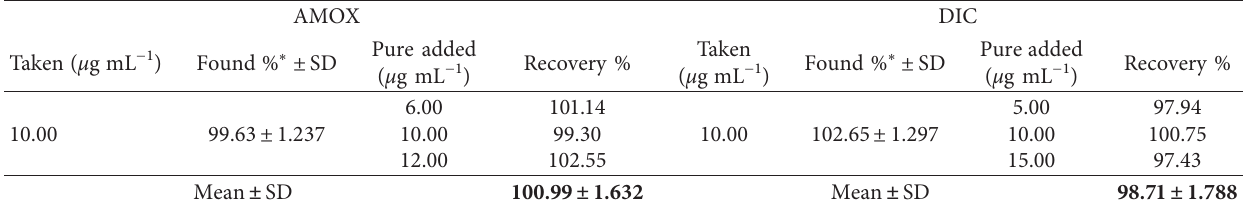
Mean ± SD 100.99±1.632 Mean ±